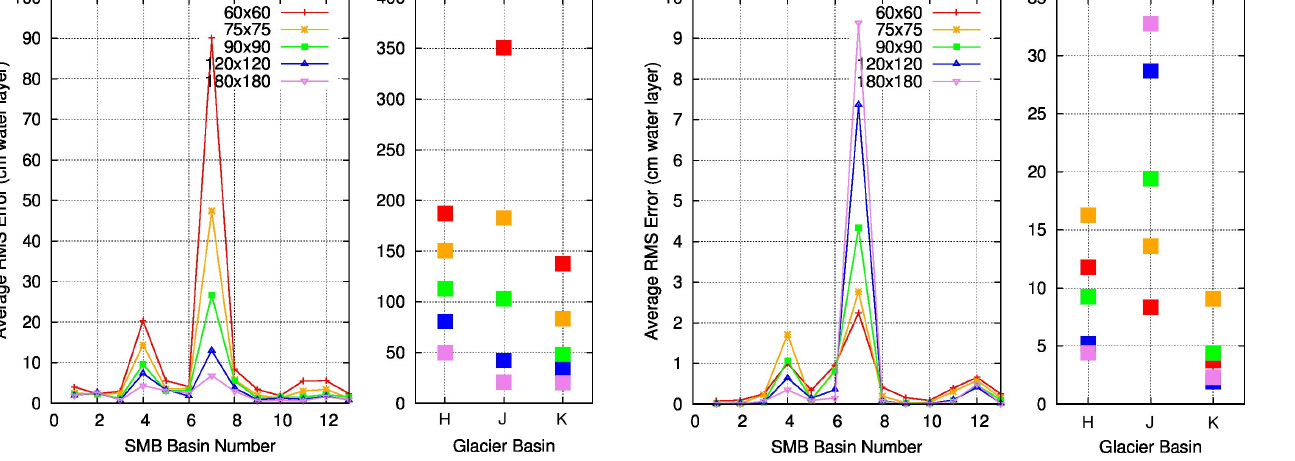
Figure 7. Average RMS difference from truth per basin for the DMB-only simulations, for data of increasing maximum degree, in SMB basins and glacial basins. Yearly windowing